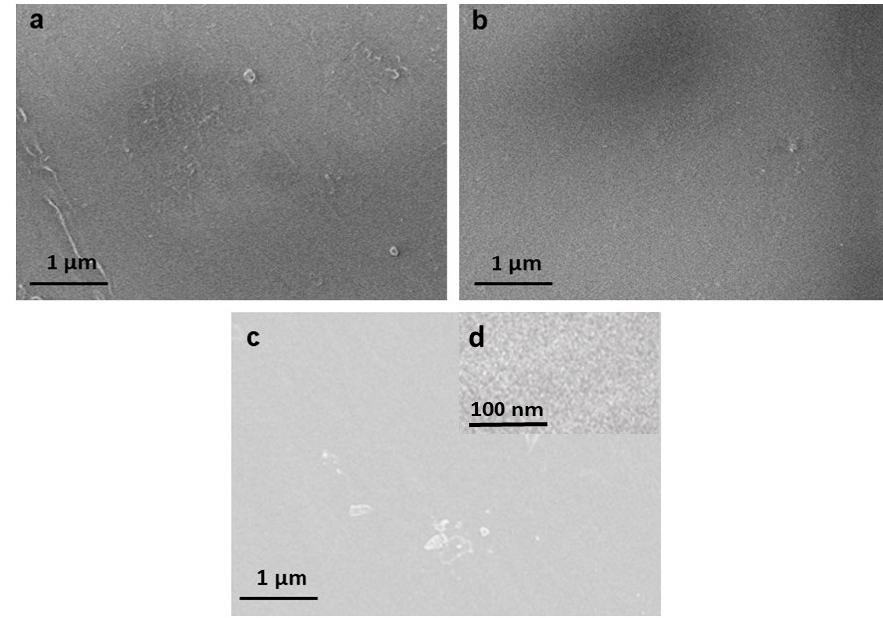
Figure 3. SEM micrographs showing Nylon 6 ( a ); Nylon 6-NH ( b ); Nylon 6-N-PEG ( c ) with an inset image of the PEG-modified surface in detail ( d